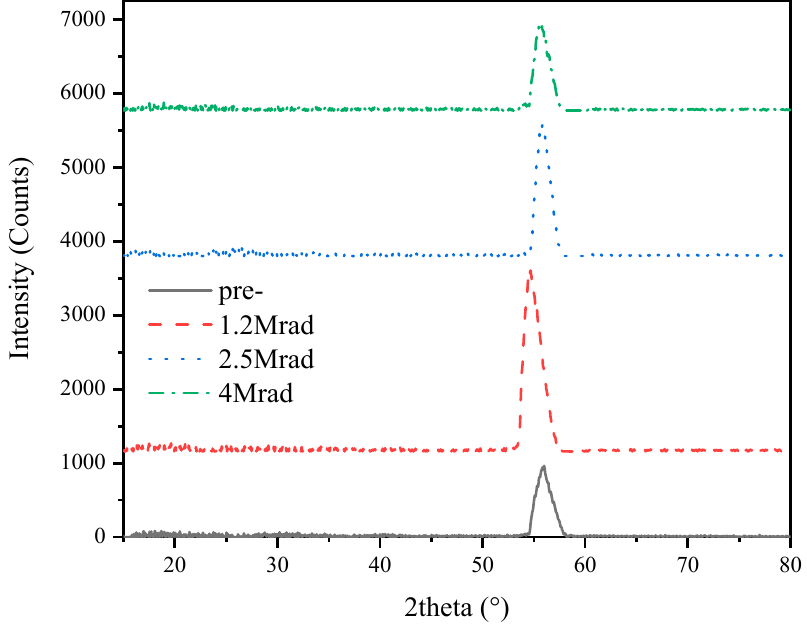
Figure 1. The grazing incidence X-ray diffraction (GIXRD) result of the Al 2 O 3 thin film.